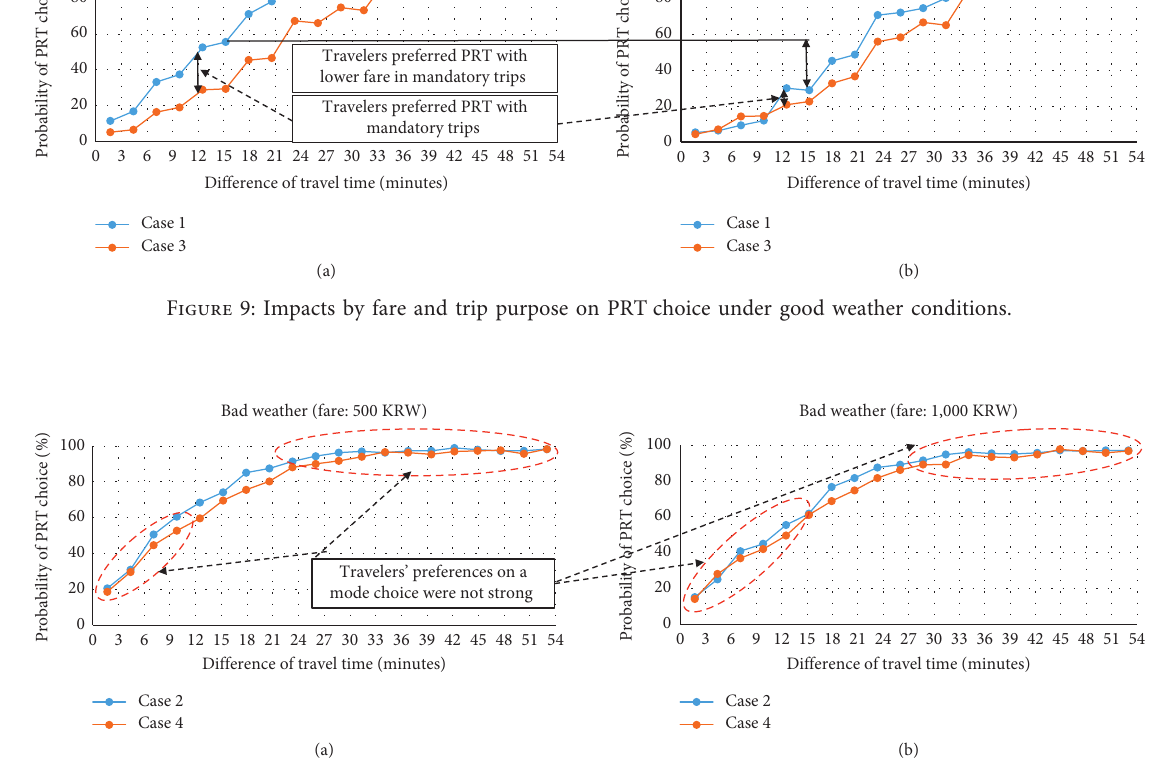
Figure 10: Impacts by fare and trip purpose on PRT choice under bad weather conditions. Table 6: Logistic regression models for 12